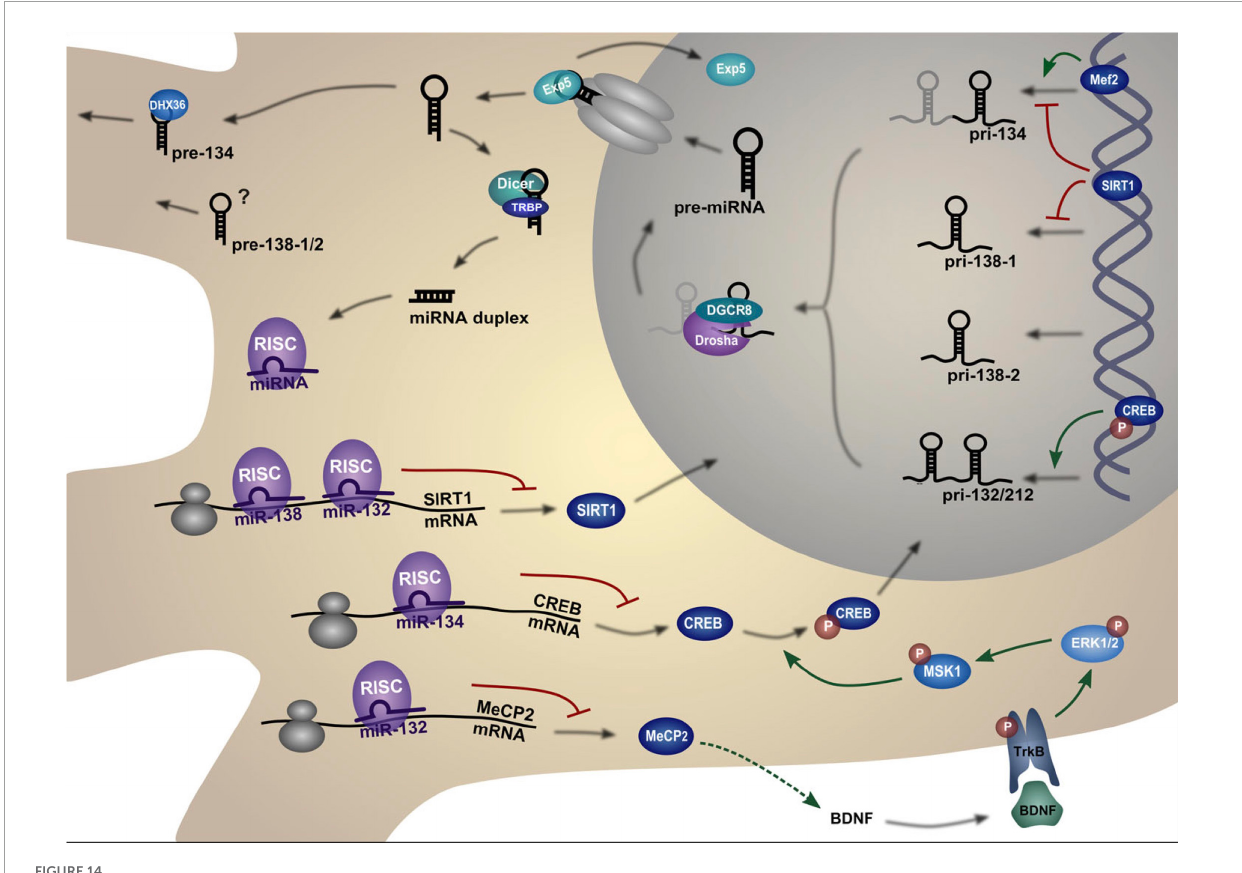
FIGURE14 Biogenesis and regulation pathways of dendritic miRNAs. The miRNA gene is transcribed into a primary miRNA transcript (pri-mRNA) which is cleaved by Drosha to generate a hairpin miRNA precursor (pre-miRNA). After nuclear export, the pre-miRNA is cleaved by Dicer to form the double-stranded miRNA duplex. One strand of this duplex, the mature miRNA, is then incorporated into the miRNA-induced silencing complex (miRISC). The miRISC complex can bind to complementary target mRNAs, thereby repressing their translation. The figure depicts those targets that are in turn regulating miRNA expression in neurons. Figure from Bicker et al. (2014), obtained by Springer Nature under license No